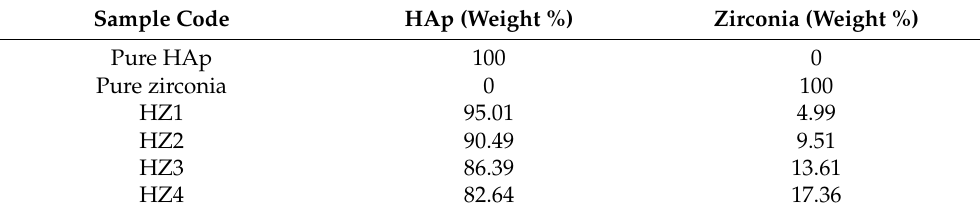
Table 1. The presence of HAp and zirconia content in the as-prepared